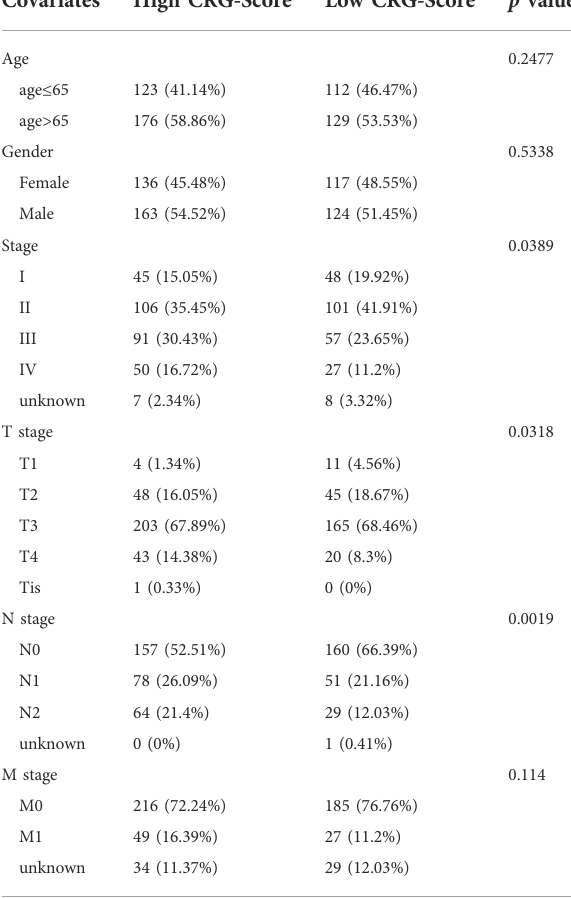
TABLE 2 Clinical information of the high CRG-Score and low CRG- Score groups.